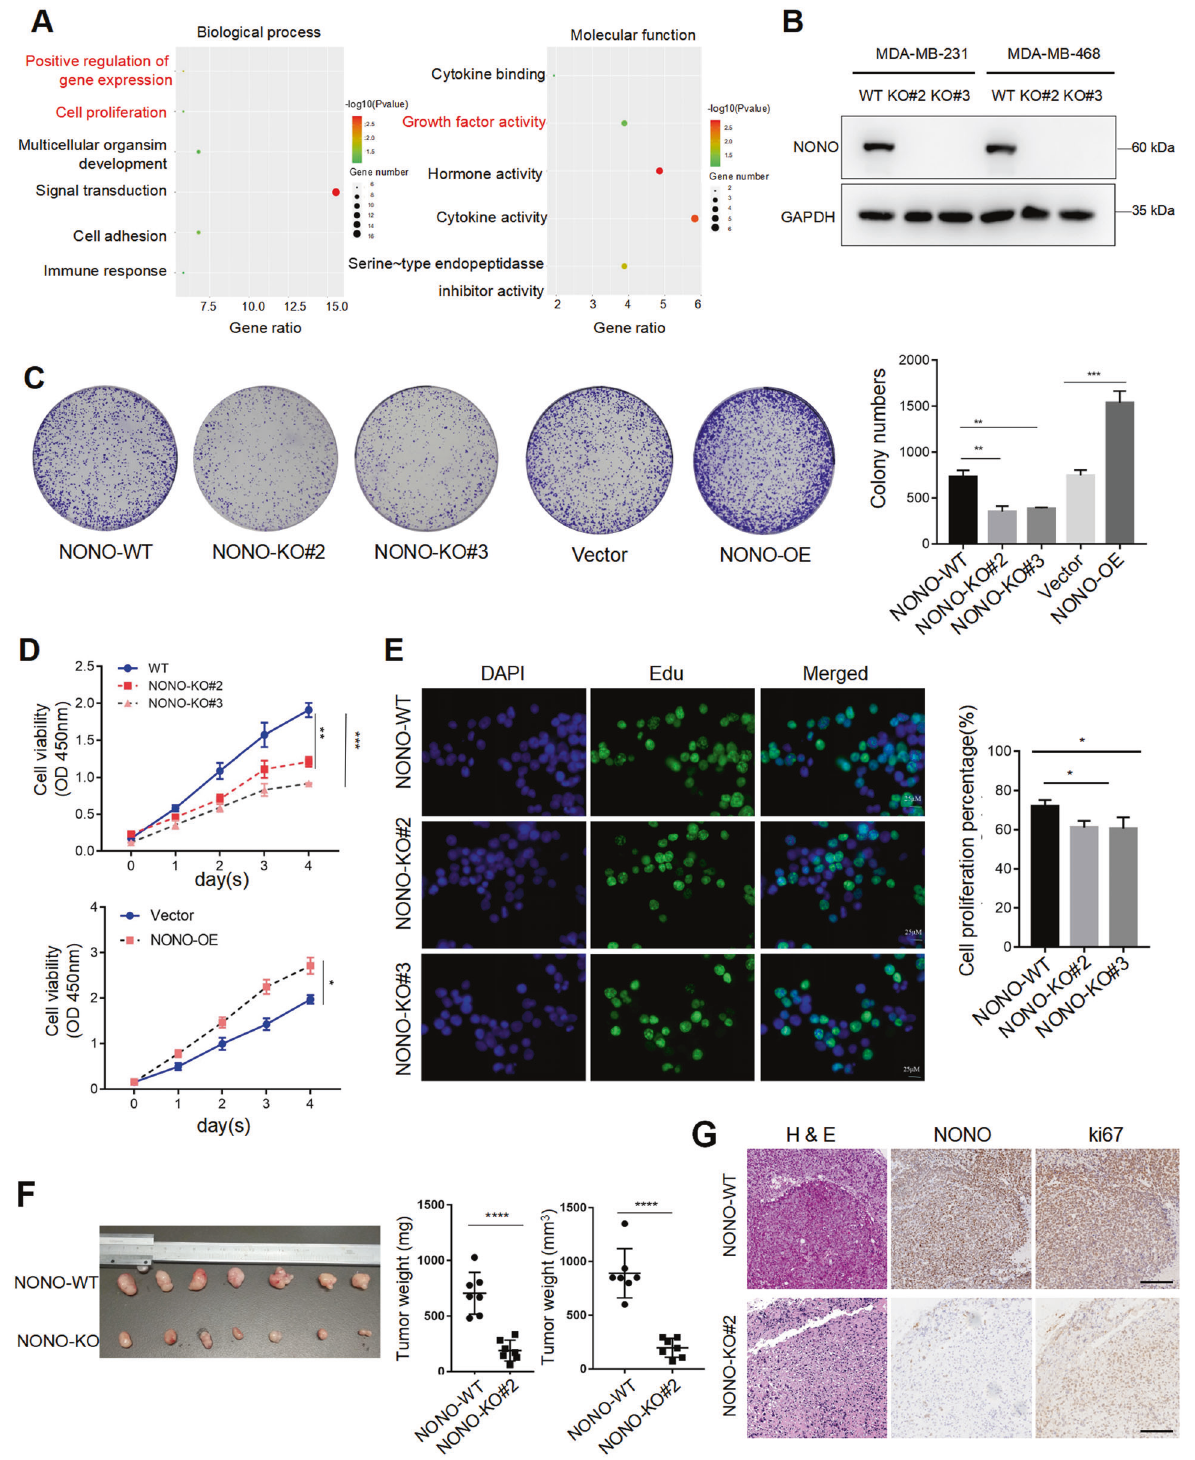
Fig. 2 NONO functions as an oncogene enhancing proliferation of TNBC in vitro and in vivo. A GO analysis showed the differently regulated genes ( n = 103) upon NONO knockdown were enriched in cell proliferation and growth factor activity. B The NONO knockout ef fi ciency by CRISPR-Cas9 was con fi rmed by western blotting in MDA-MB-231 and MDA-MB-468 cells. C – E The effect of NONO on the cell viability of MDA-MB-231 was determined by colony formation ( C ), CCK-8 assay ( D ), and immuno fl uorescence analysis with Edu ( E ). Knockout of NONO expression signi fi cantly inhibited cell proliferation, while ectopic overexpression of NONO promoted cell proliferation. Scale bar = 100 μ m (colony) or 20 μ m (Edu). OE, overexpression. F The volume and weight of subcutaneous tumor was signi fi cantly diminished upon NONO knockout ( n = 7 per group). G The xenografts were subjected to H&E and IHC staining with NONO, ki-67. Scale bar = 200 μ m (×100). All values shown are mean ± SD of triplicate measurements and have been repeated three times with similar results ( C – E ). * P < 0.05; ** P < 0.01; *** P < 0.01 versus corresponding